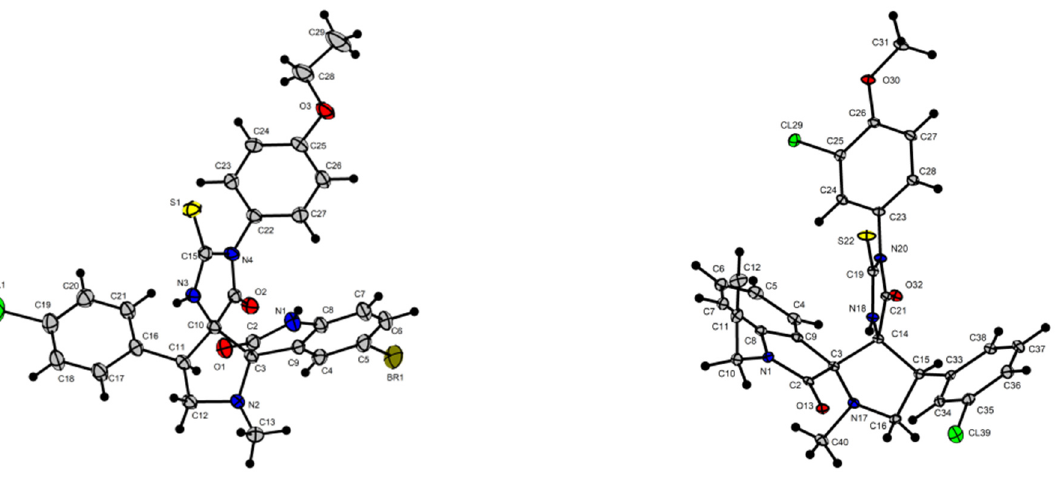
Figure 4. Molecular structures of dipiro -indolinones 29 ( left ) and 69 ( right ); atoms are displayed as thermal ellipsoids at a 30% probability level.